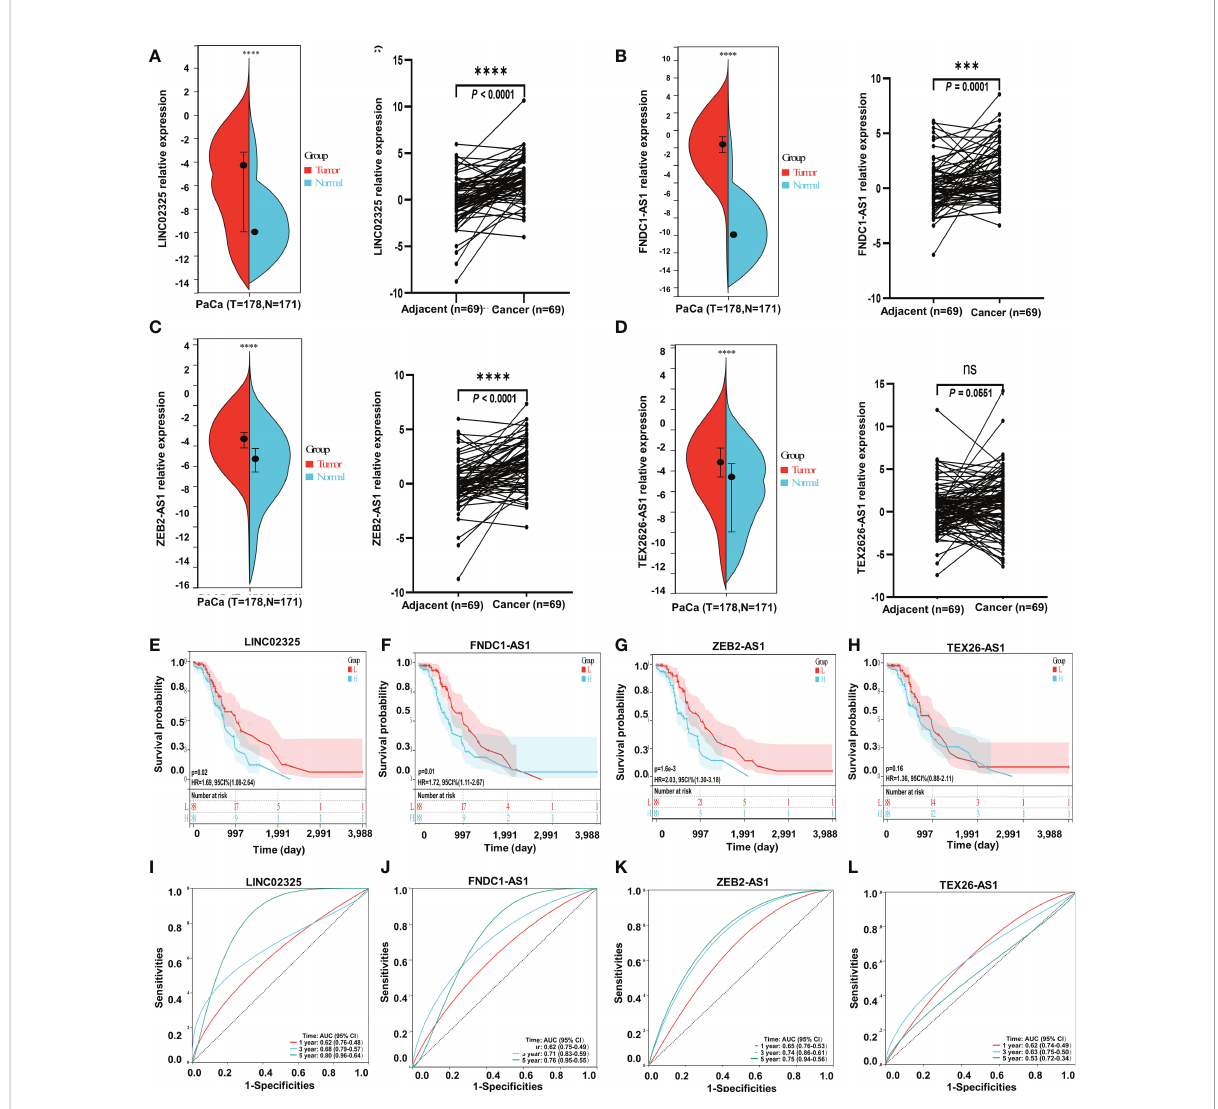
FIGURE 4 The expression levels of four IRlncRNAs and con fi rmation of the four IRlncRNA prognostic signatures ’ prediction ability. (A) LINC02325. (B) FNDC1-AS1. (C) ZEB2-AS1. (D) TEX26-AS1. *** means P < 0.001, “ ns ” means no signi fi cance. “ **** ” means p < 0.0001. (E – H) Kaplan − Meier curve analysis of the correlation between the expression of the four IRlncRNAs and the prognosis of PaCa. (I – L) ROC curves for the prognostic prediction of four IRlncRNAs at 1-, 3-, and 5-year survival